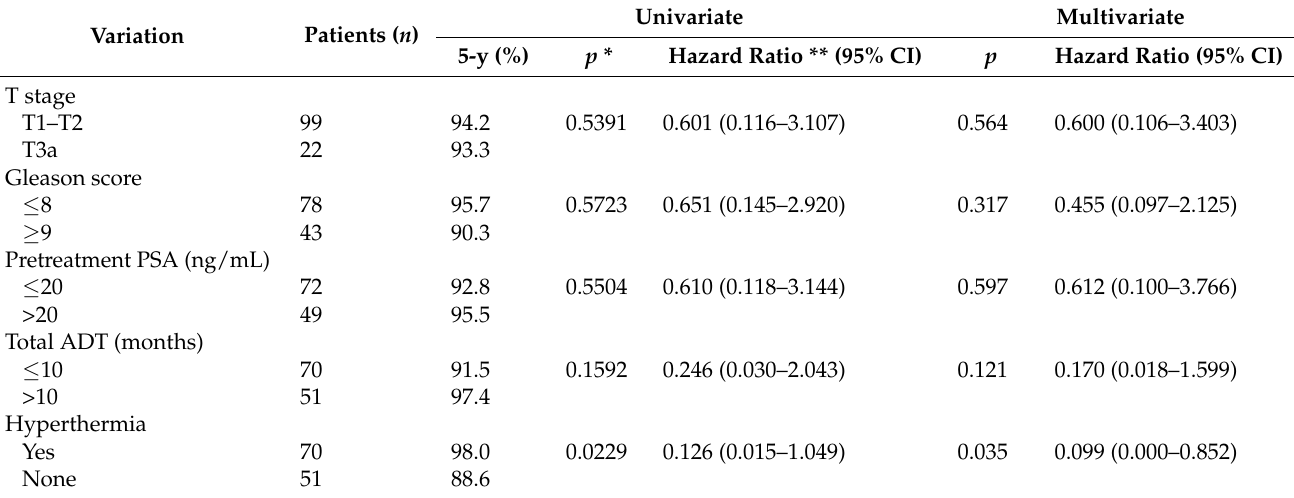
Table 4. Univariate and multivariate analyses of certain factors for clinical relapse-free survival in 121 patients treated with IMRT with or without regional